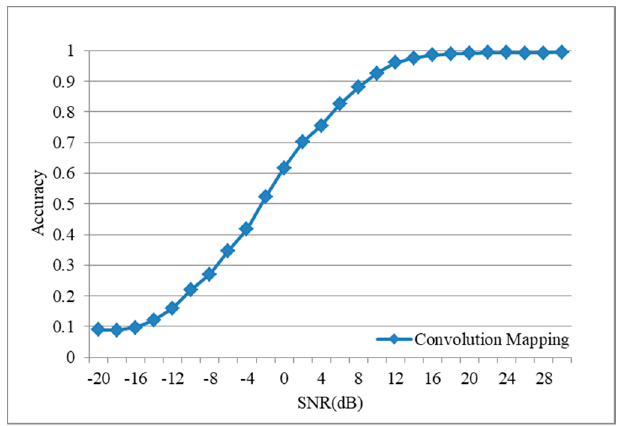
Figure 7. Classification accuracy of each SNR of dataset Sig1024_2 with 2 different sampling rates.